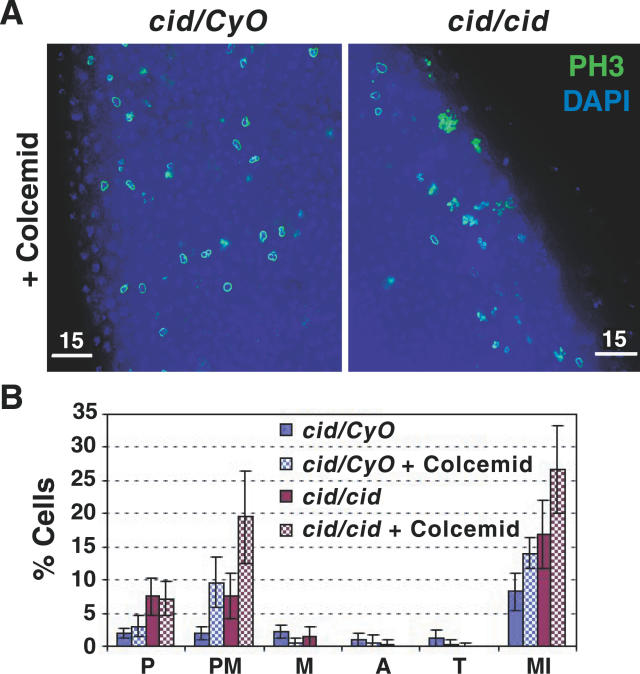

cid Mutants Retain an Intact SAC Response to Microtubule Depolymerization
cid null and heterozygous embryos were treated with colcemid to determine if they have an intact SAC response to spindle disruption. Both cid/CyO and cid/cid cells were able to delay the cell cycle in response to spindle disruption (A), as evidenced by an approximately 2-fold increase in mitotic index and an accumulation of cells in prometaphase (B).A, anaphase; M, metaphase; MI, mitotic index; P, prophase; PM, prometaphase; T, telophase.Scale bars indicate 15 μm.